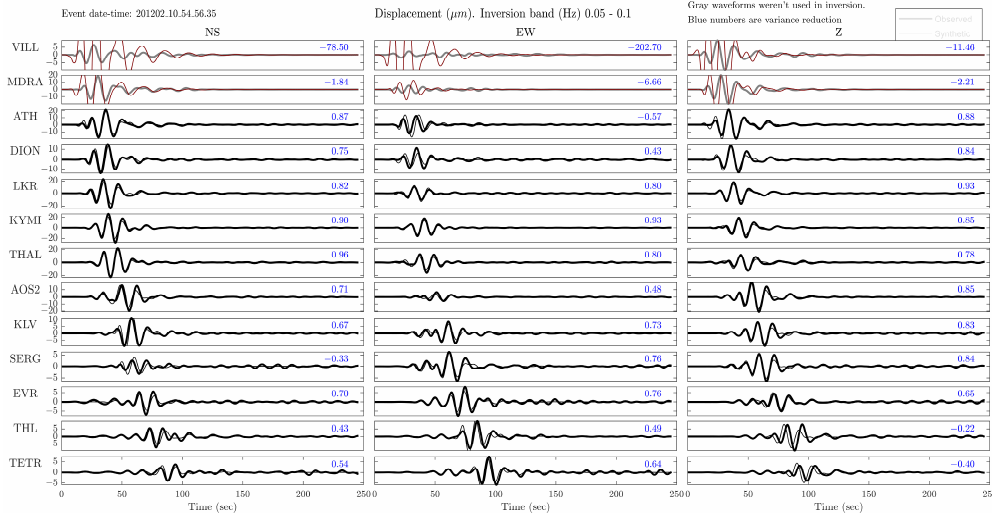
Figure A8. Comparison between synthetic (red) and observed (black) waveforms. Faded waveforms (stations MDRA and VILL) were not used in the inversion. For each subplot, the variance reduction is indicated at the top